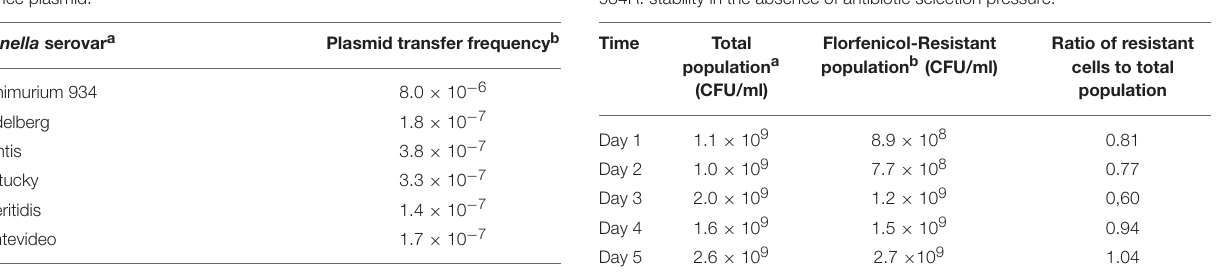
TABLE 5 | In vitro maintenance of Newport MDR plasmid in S . Typhimurium 934R: stability in the absence of antibiotic selection